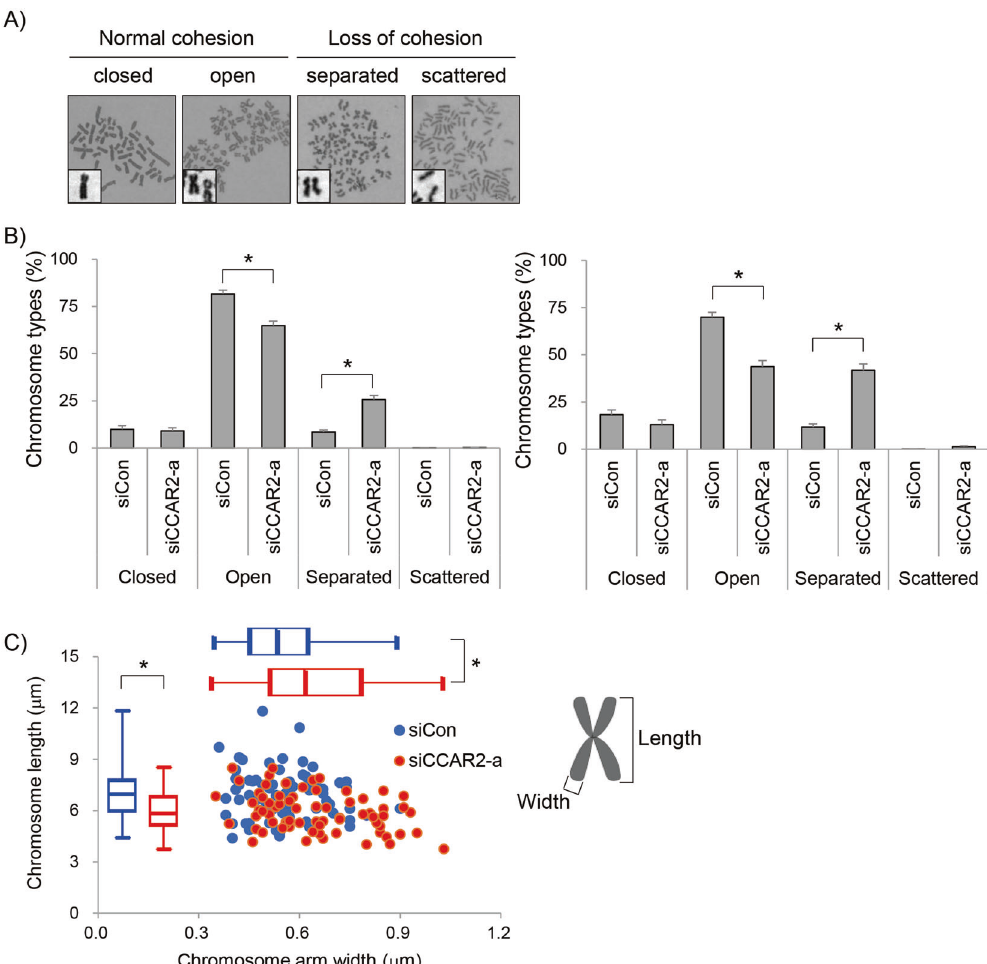
Fig. 3 CCAR2 de fi ciency induces premature sister chromatid separation and abnormal chromosome condensation. A − C Metaphase spreads were prepared following treatment of cells with 25 ng/ml colcemid for 6 h, or 50 μ M monastrol for 3 h followed by release in the presence of 20 μ M MG132 for 1.5 h. A Cohesion phenotypes were classi fi ed into four categories: (i) closed, sister chromatid arms are unresolved; (ii) open, sister chromatid arms are resolved; (iii) separated, sister chromatid arms and centromere are separated, but remain near each other; (iv) scattered, individual sister chromatids are fully scattered. The former two states are normal, but the latter two indicate loss of cohesion. B The metaphase spread with each cohesion phenotype was counted from out of more than 20 metaphase spreads per experiment. The experiment was repeated independently ( N = 7). The total number of metaphase spreads examined is as follows; colcemid-treated cells in left panel, siCon, n = 195; siCCAR2-a, n = 194; monastrol/MG132-treated cells in right panel, siCon, n = 182; siCCAR2-a, n = 154. Data are expressed as the mean ± SEM. * p < 0.05, signi fi cantly different from corresponding siCon cells (Mann – Whitney U test). C Metaphase spreads were prepared following treatment of cells with 50 μ M monastrol for 3 h followed by a wash-out in the presence of 20 μ M MG132 for 1.5 h. The longest chromosome from each spread (chromosome 1) was analyzed. Ten metaphase spreads per experiment were examined and the experiment was repeated independently ( N = 7, n = 70). The chromosome length and arm width were plotted, and also represented in box- and-whisker plot. Box, interquartile range; whisker, min and max; bar, median. * p < 0.05, signi fi cantly different from corresponding siCon cells (two-sided unpaired Student ’ s